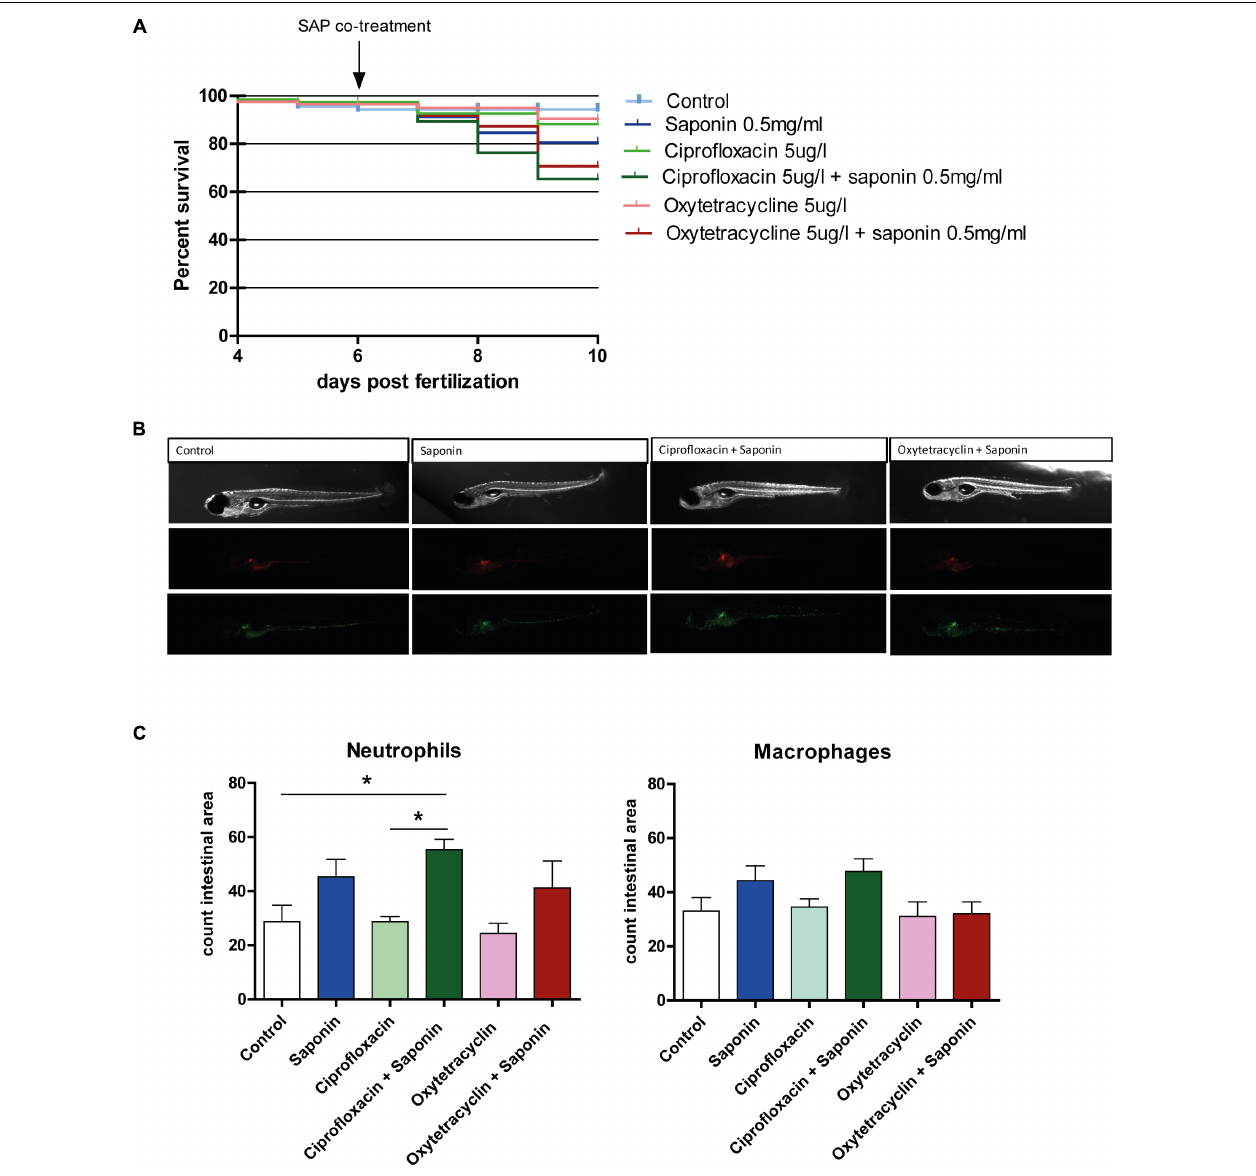
FIGURE 4 | Effect of antibiotic exposure on saponin-immune-stimulation. (A) Percent survival of zebrafish exposed to control (E3), ciprofloxacin (4–9 dpf) (5 ug/L) or oxytetracycline (4–9 dpf) (5 ug/ml) + / − saponin (0.5 mg/ml) from 6–9 dpf ( n = 100 fish/treatment) (Log-rank Mantel-Cox Test for Chi-square). (B) Representative pictures of the antibiotic/saponin-treated Tg(mpeg1:mCherry/mpx:eGFPi 114 ) fish displaying green neutrophils and red macrophages. (C) Quantification of neutrophils and macrophages in the intestinal area ( n = 10 fish/group) (one way ANOVA Kruskal-Wallis test with Dunn’s Multiple comparison Post-Test, mean ± SEM, ∗ p < 0.05). Two independent experiments were performed and one representative experiment is